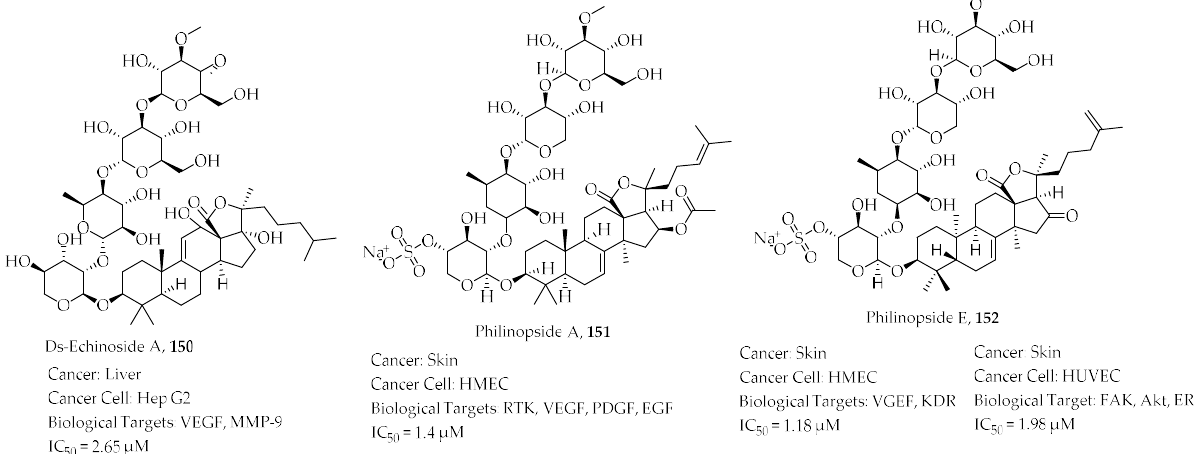
Figure 36. Structures of a non-sulfated triterpene glycoside Ds-Echinoside A and two sulfated saponins Philinopside A and Philinoside E with a summary of their biological activity towards selected cancer targets.